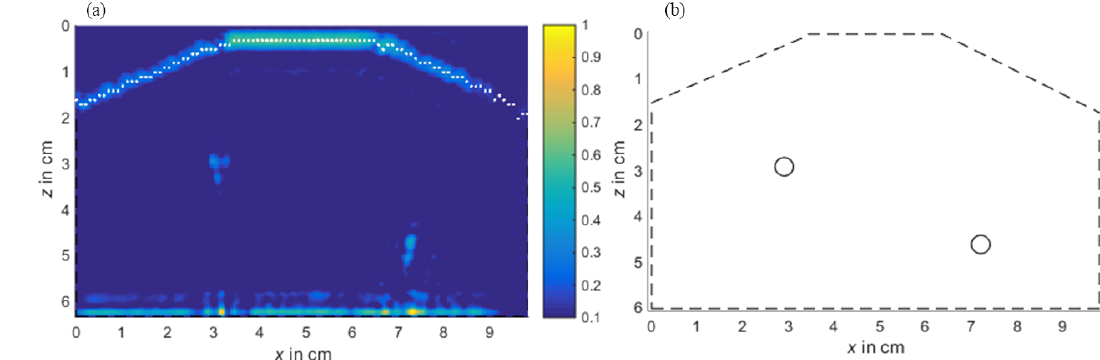
Figure 8. (a) Reconstructed image with estimated boundary (white); (b) ideal geometry sketch.